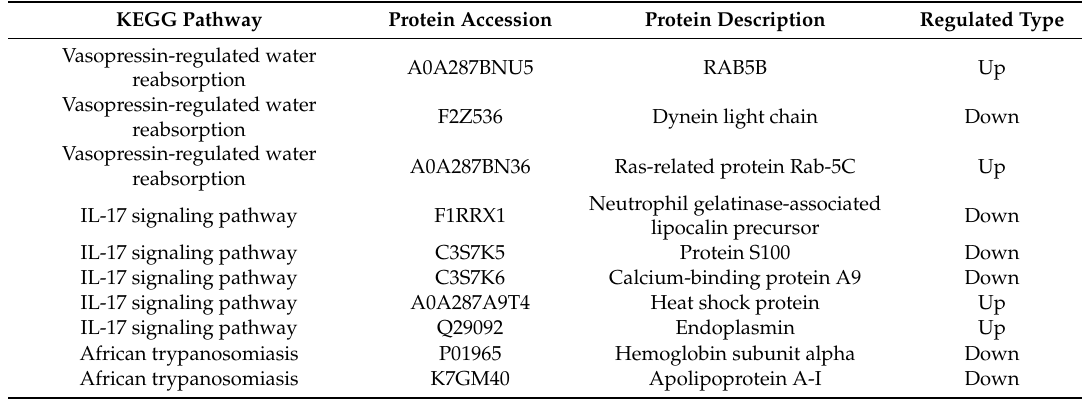
Table 3. KEGG pathway enrichment of PC vs. CC differential proteins . Note: PPAR, peroxisome proliferator-activated receptor.